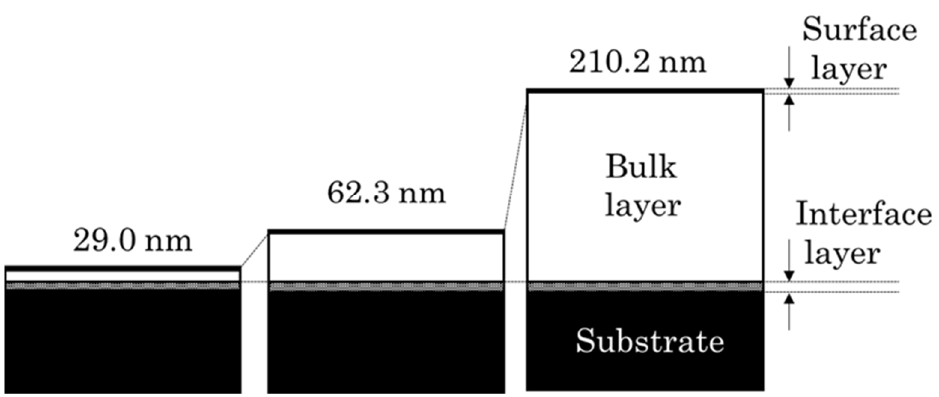
Figure 3. PLC film structural model prepared by a radio-frequency plasma CVD process.